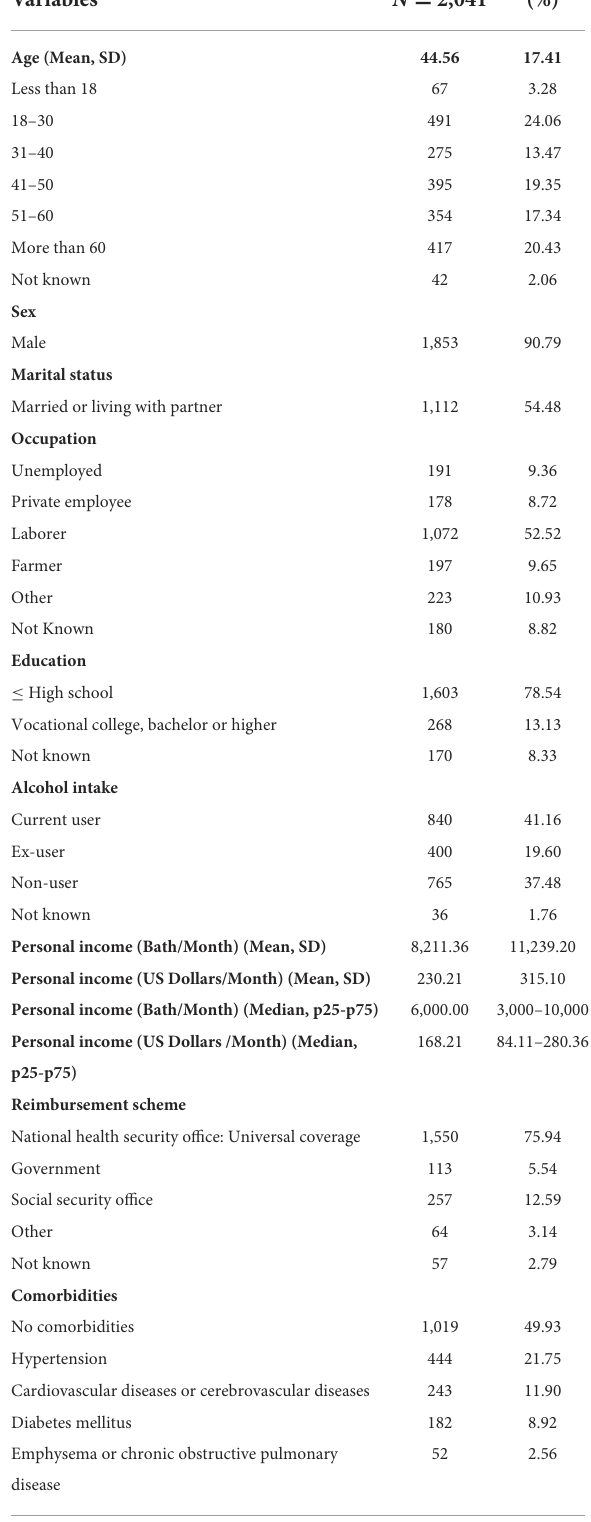
TABLE 1 Sociodemographic, clinical characteristics, and smoking pattern of the participants.